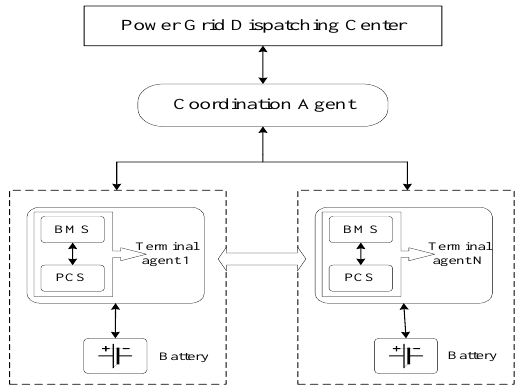
Figure 3. Multi-agent collaborative control frame of the energy storage system.